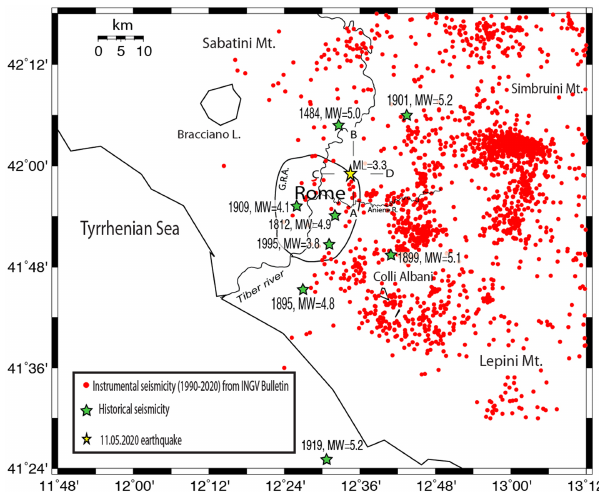
Figure 1. Map showing the seismicity of Rome’s area and main- shock location (yellow star) of the 11 May 2020 earthquake. A–B and C–D are the cross-sections in Fig. 4b. G.R.A. is the beltway around Rome. Table 1. List of earthquakes that caused documented damage in the present G.R.A. The oldest events (italic in table) are not constrain- able. (Data from Guidoboni et al., 2018; Rovida et al., 2020; Tertul- liani et al.,